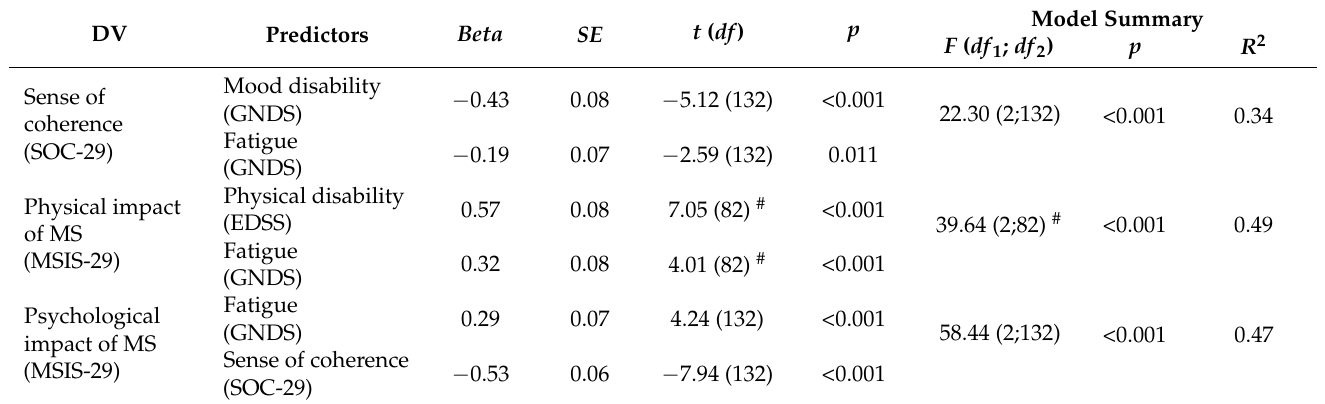
Table 6. Results of three separate stepwise regression